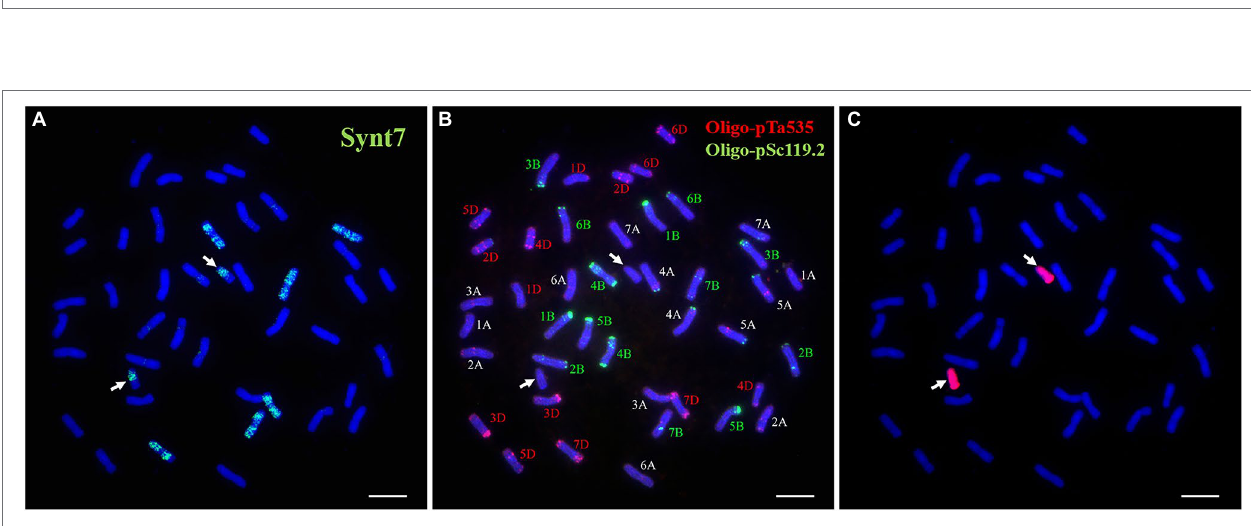
FIGURE 2 | Sequential FISH and GISH analyses of the wheat- P. huashanica ditelosomic addition line DT23. (A) FISH painting analysis of DT23 using probe Synt7 (green). (B) FISH identification of DT23 using Oligo-pSc119.2 (green) and Oligo-pTa535(red). (C) P. huashanica genomic DNA was used as a probe for GISH (red). Arrows indicate the introduced P. huashanica chromosomes in DT23. Scale bar: 10 μ